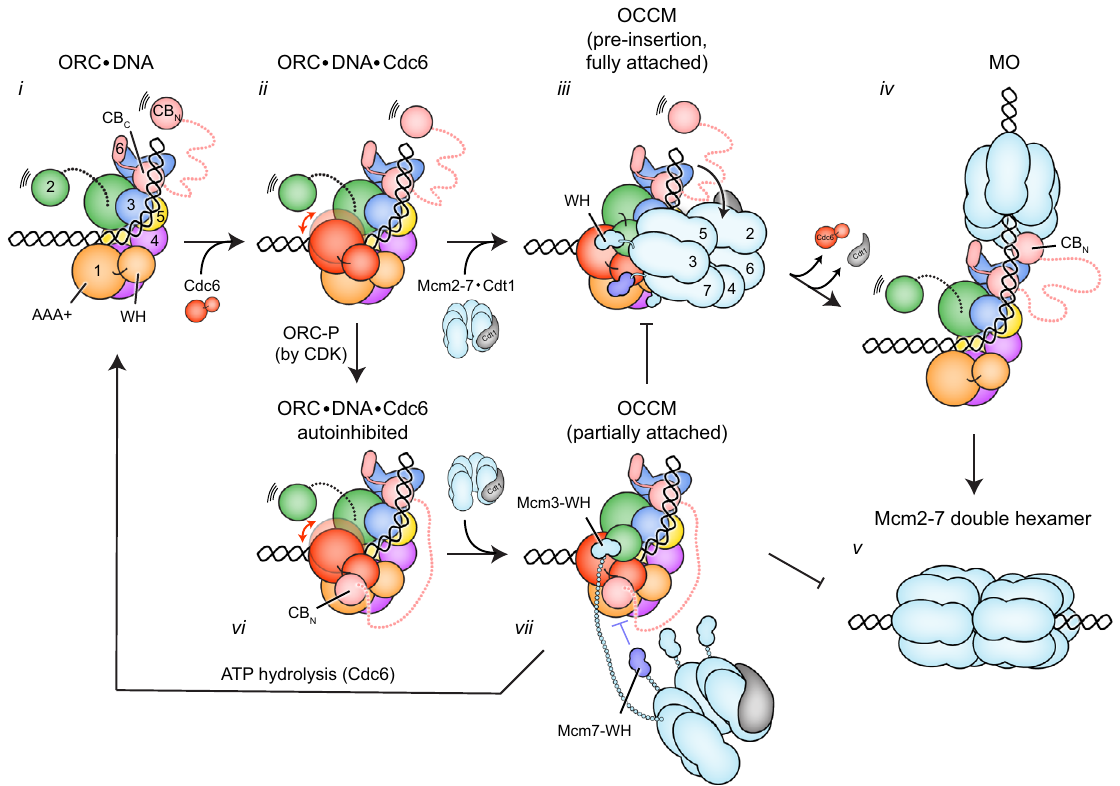
Fig. 6 Model for the regulation of Mcm2-7 loading by the N-terminal domain of Orc6. i ORC binds and bends DNA. The Orc6-CB N is fl exibly tethered to ORC. ii Cdc6 binds to ORC·DNA. The ternary complex can adopt different ring conformations. iii Mcm2-7 and Cdt1 are recruited and fully attach to the ORC·Cdc6 ring. The bent DNA is positioned near the Mcm2/5 gate. iv The fi rst Mcm2-7 hexamer is loaded onto DNA and held in proximity to ORC by the Orc6-CB N in the MO complex. Cdc6 and Cdt1 have been released. v The MO complex recruits a second Cdc6, Cdt1, and Mcm2-7 complex to load another hexamer by a similar mechanism, yielding double Mcm2-7 hexamers. vi Orc6-CB N docking onto the ORC·Cdc6 ring yields an autoinhibited